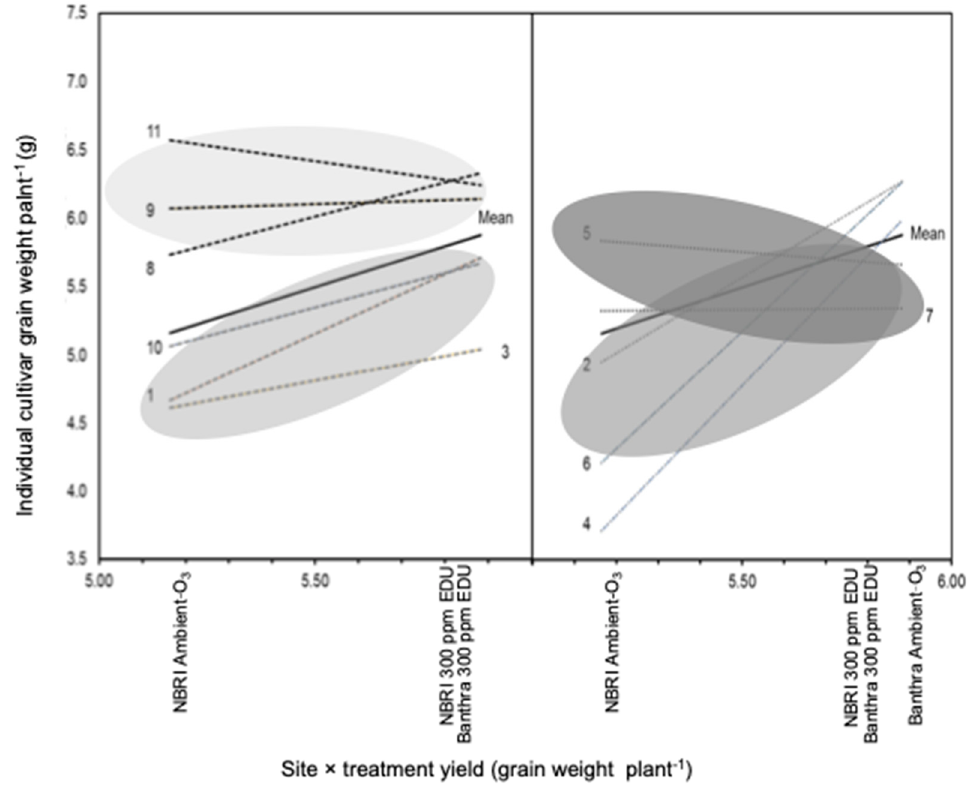
Figure 4. Regressions between the mean grain weight plant − 1 of all the cultivars at each site and treatment (x-axis) and the individual grain weight plant − 1 (y-axis) of each of the 11 wheat cultivars. ( A ) Grouping of well adapted (8, 9 and 11) cultivars and poorly adapted (1, 3 and 10) cultivars. ( B ) Grouping of cultivars adapted to low-yield conditions (5 and 7) and cultivars adapted to high-yield (2, 6 and 4) conditions. (1) PBW-373, (2) PBW-502, (3) PBW-154, (4) WH711, (5) PBW-343, (6) DBW-17, (7) LOK-1, (8) KUNDAN, (9) WR-544, (10) HUW-234, (11) PBW-550.